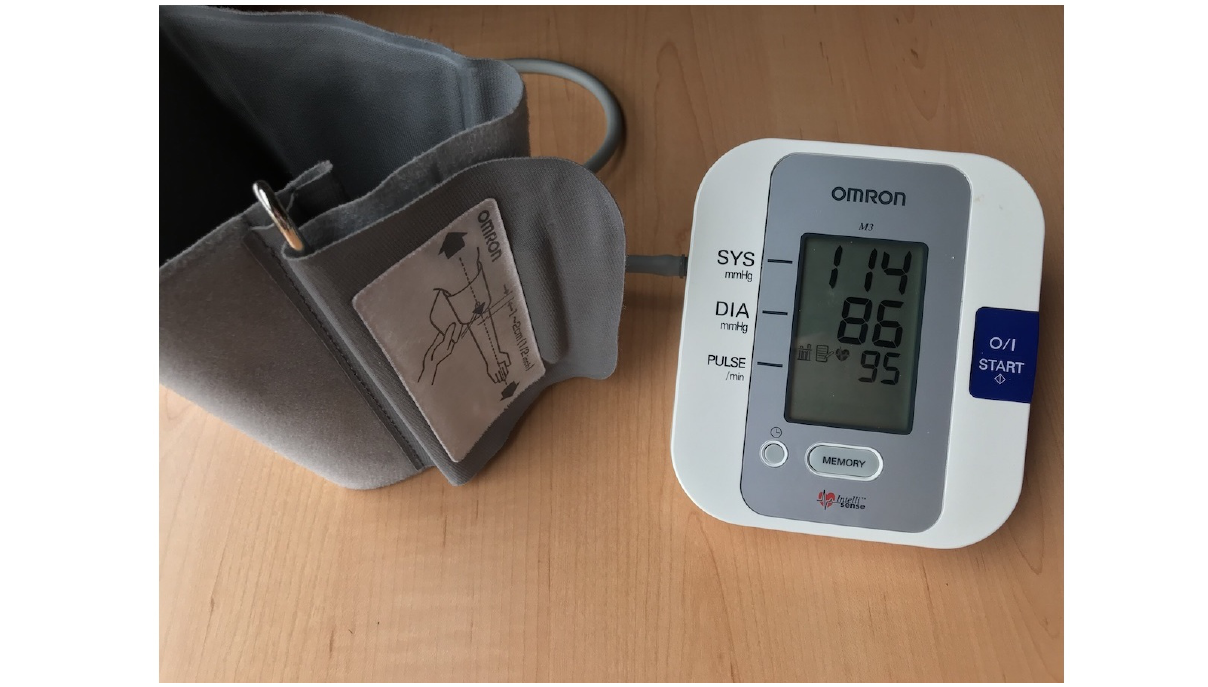
Figure 2. The Omron M3 blood pressure